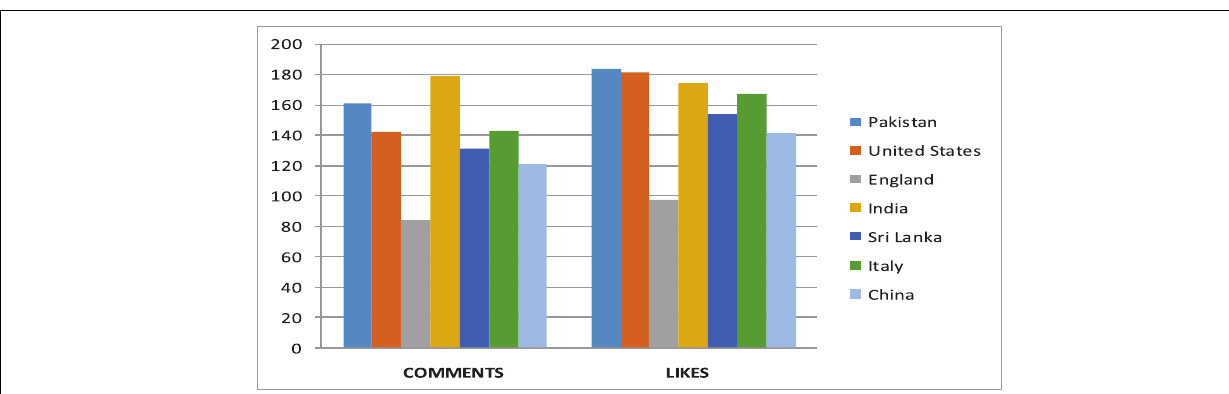
FIGURE 3 | Impressions vs. estimated earnings.